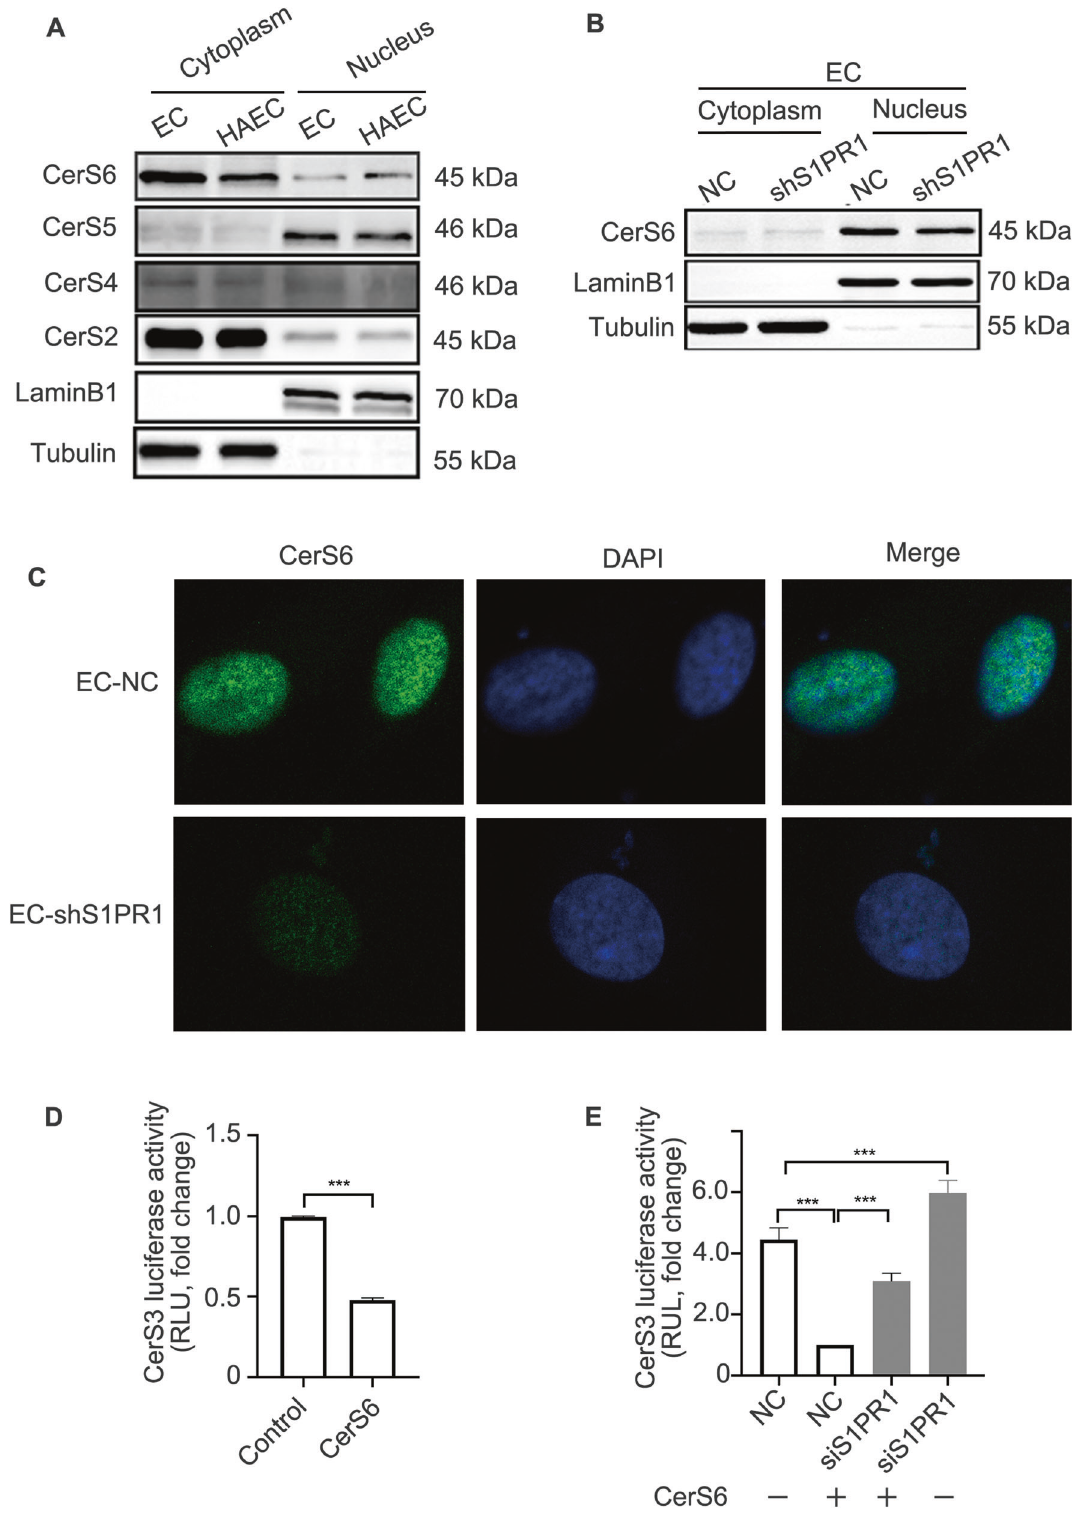
Fig. 7 S1PR1-induced nuclear translocation of CerS6 inhibits CerS3 expression at the transcriptional level. A The protein expression of CerS2/4/5/6 in the cytoplasm and nucleus of HAECs was detected by WB. B The protein expression of CerS6 in the cytoplasm and nucleus of EC-shS1PR1 was assessed by WB. C The level of CerS6 in the cytoplasm and nucleus of ECs-shS1PR1 was detected by IF. Scale bar: 50 μ m. D Luciferase assays with the CerS3 promoter were performed in HK-293T cells transfected with pDNA-CerS6 for 48 h. E Luciferase assays with the CerS3 promoter were performed in HK-293T cells pretreated with siS1PR1 for 24 h and then transfected with pDNA-CerS6 for 48 h.